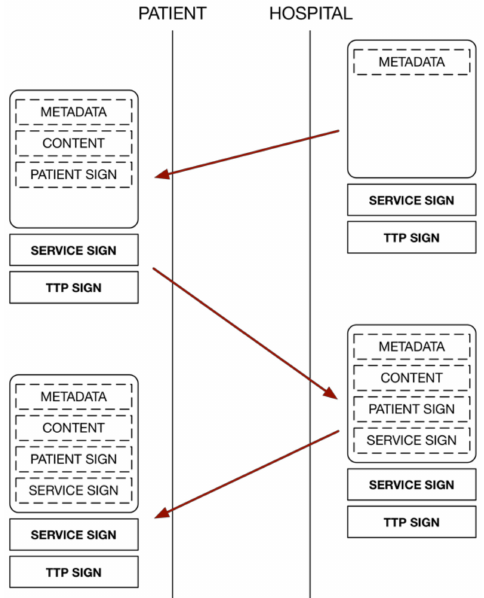
Figure 3. Information exchange model based on the concept of the